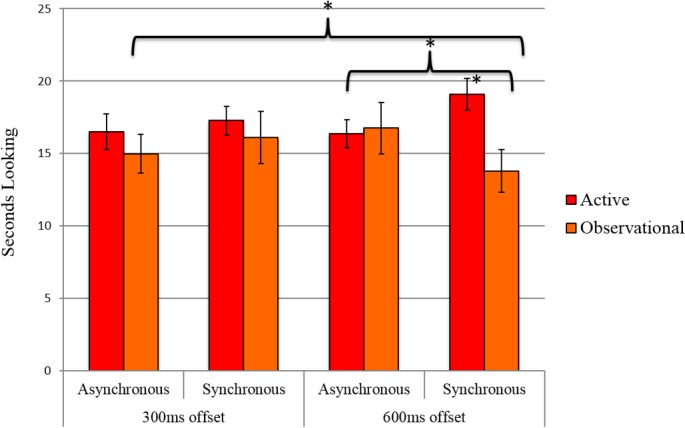
Active and Observational Results.Infants in the Active (Exp 1) and Observational (Exp 2) conditions differed in the amount of time they looked to synchronous videos during 600 ms offset trials. (*p < .05, error bars represent standard errors).